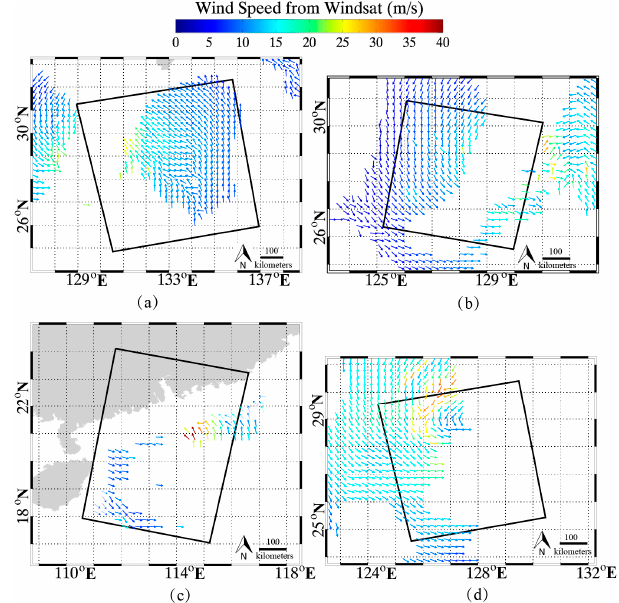
Figure 4. Windsat wind maps corresponding to the four VH-polarization GF-3 SAR images in Figure 2, in which rectangles represent the coverage of the images. ( a ) Windsat wind map from typhoon Noru on 4 August 2017 at 09:18 UTC. ( b ) Windsat wind map from typhoon Noru on 4 August 2017 at 21:18 UTC. ( c ) Windsat wind map from typhoon Hato on 22 August 2017 at 22:30 UTC. ( d ) The Windsat wind map from typhoon Talim on 16 September 2017 at 09:36 UTC.